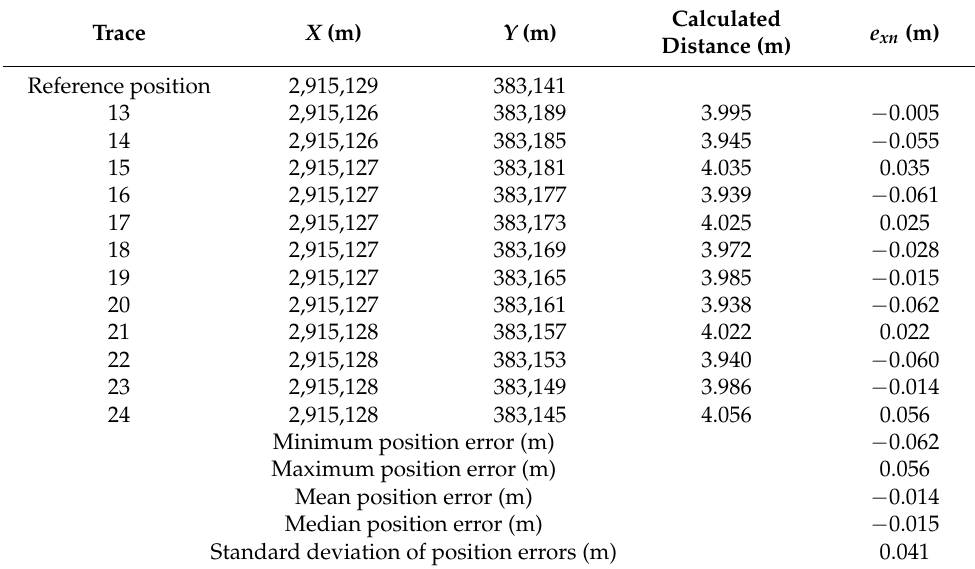
Table 3. Measured position coordinates using D-GPS and position errors of the 12 studied traces. Position errors are measured with respect to the ideal spacing of 4 m giving a relative mean and standard deviation of about 0.35% and 1%, respectively.